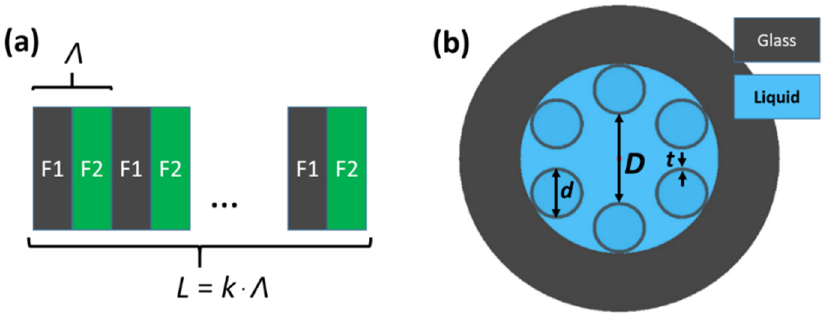
Figure 1. ( a ) Model of the investigated long-period fiber grating (LPG) formed as a composition of the alternating segments of fibers F1 and F2. The total length L of the LPG is equal to the grating period Λ times k , where k = 60 is the number of repetitions of a single period. ( b ) Cross-section of the negative-curvature hollow core fiber (NCHCF). The marked dimensions D , d and t were used to determine the optical parameters of the fiber and LPG; their values for the F1 and F2 fibers can be found in the main text below.